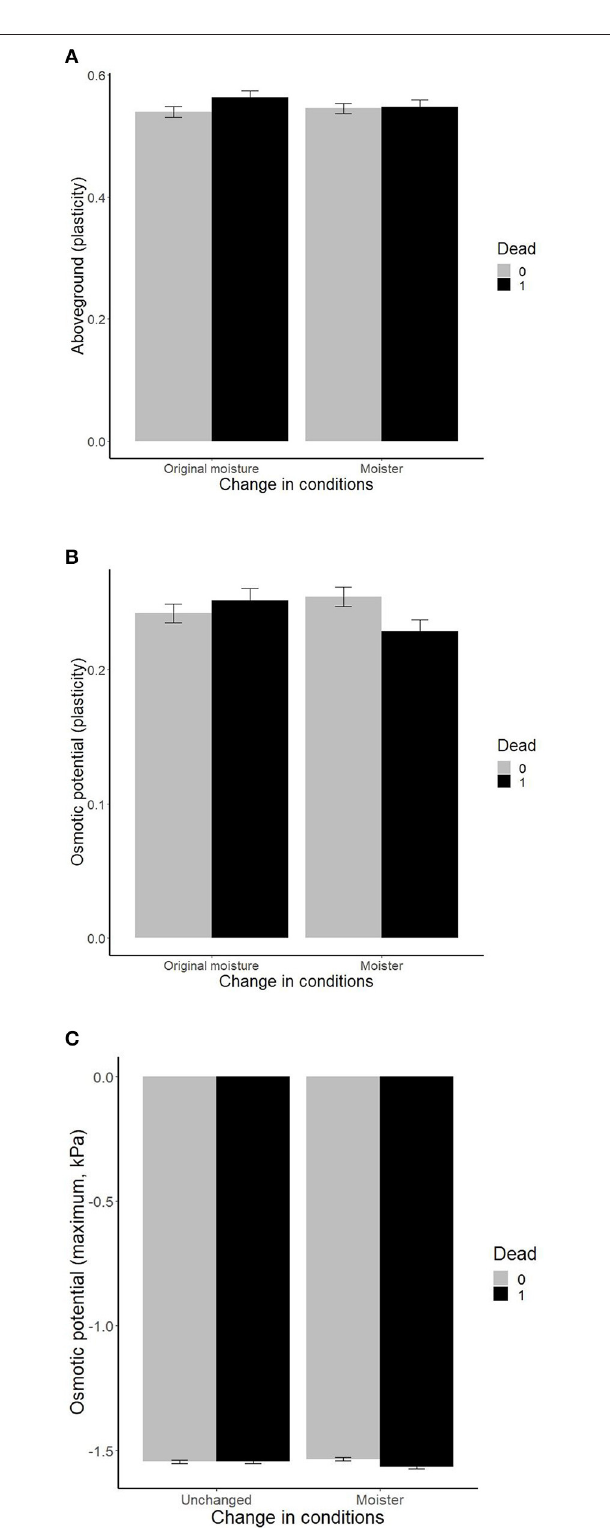
FIGURE 2 | Effects of plant traits [ (A) plasticity in aboveground biomass, (B) plasticity in osmotic potential, and (C) maximum values of osmotic potential]